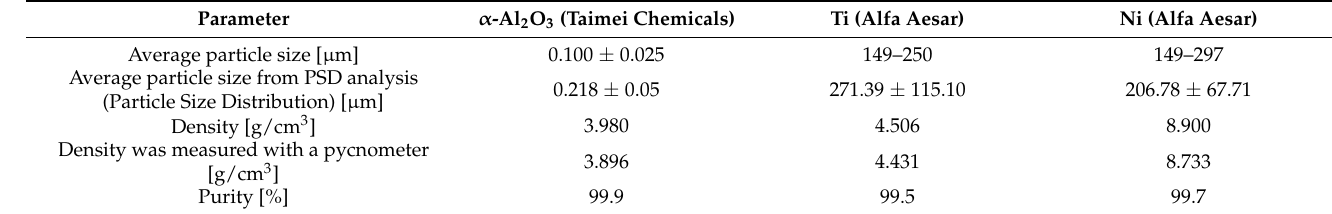
Table 2. Parameters of raw